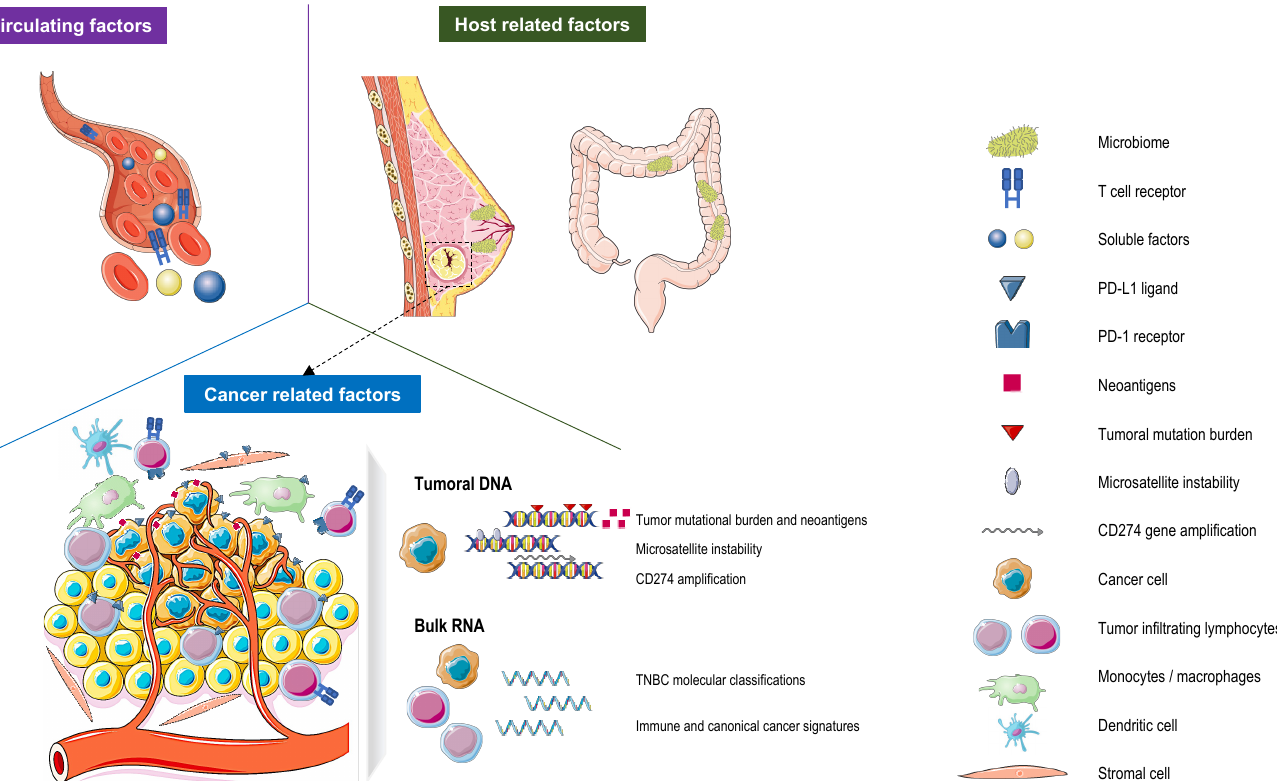
Figure 1. Currently validated and evolving predictive biomarkers for response to immune checkpoint inhibitors (ICIs) in patients with TNBC. Abbreviations. PD-L1: programmed death-ligand protein 1; PD-1: programmed